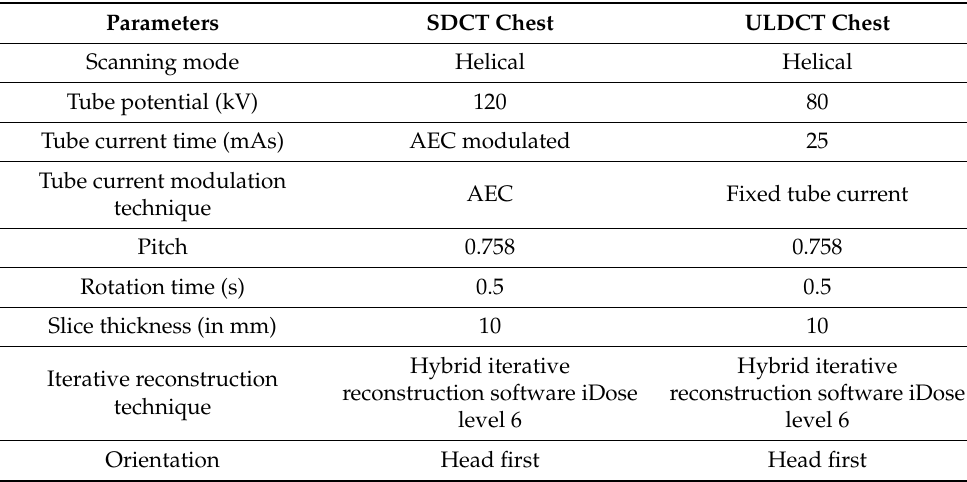
Table 1. Detailed acquisition parameters of SDCT and ULDCT